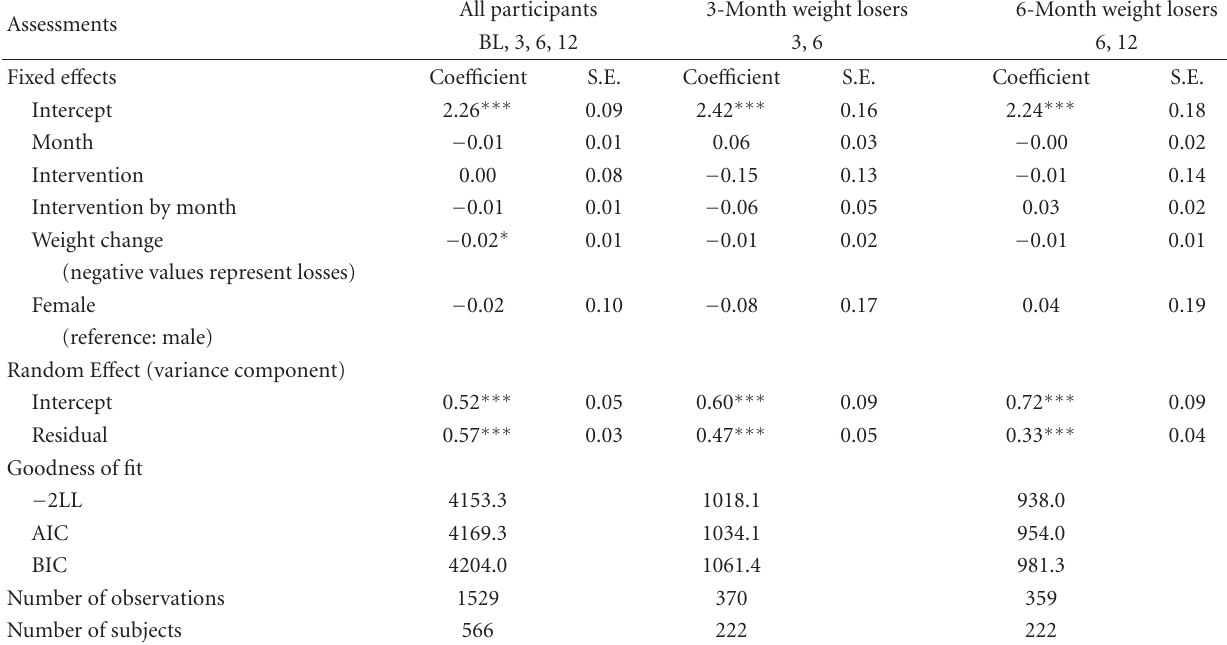
Table 4: Changes in controlled